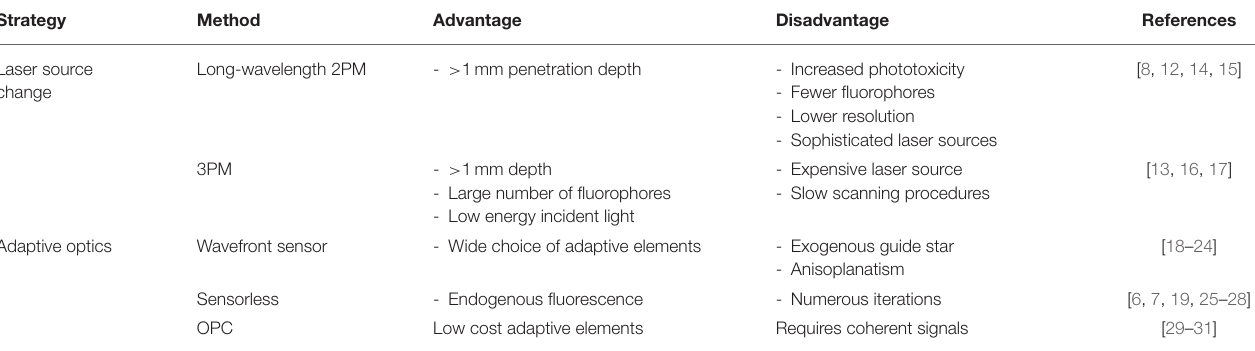
TABLE 1 | Strategies for improving 2PM deep brain